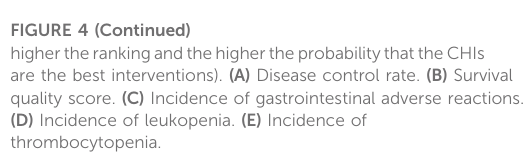
FIGURE 4 Surface under the cumulative ranking curve area plots for each outcome analyzed (The larger the area under the curve, the